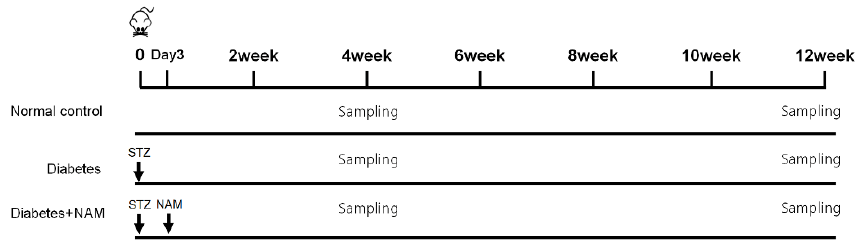
Figure 1. Timetable of the experimental design. Serum glucose values were assessed at 3 days after induction of diabetes. From the day when diabetes was confirmed, the rats in the nicotinamide group were given 500 mg/kg/day oral administration of nicotinamide in drinking water for 4 weeks or 12 weeks. NAM, nicotinamide; STZ, streptozotocin.